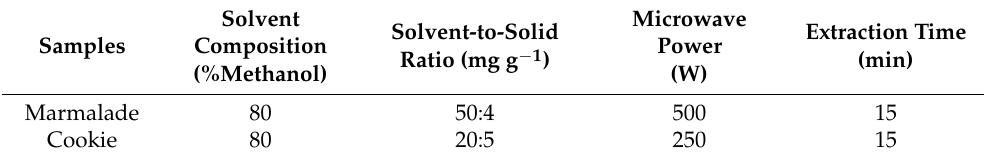
Table 4. Optimized MAE conditions to extract resveratrol from marmalade and cookie samples.